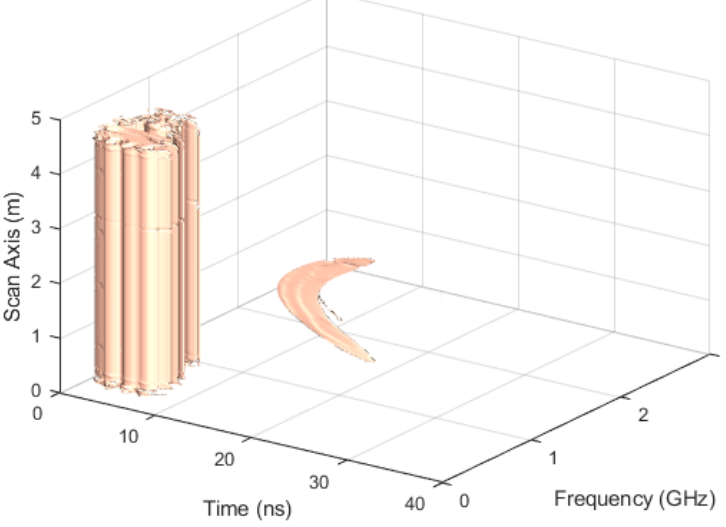
Figure 6. Three-dimensional (3D) Frequency property data of GPR.